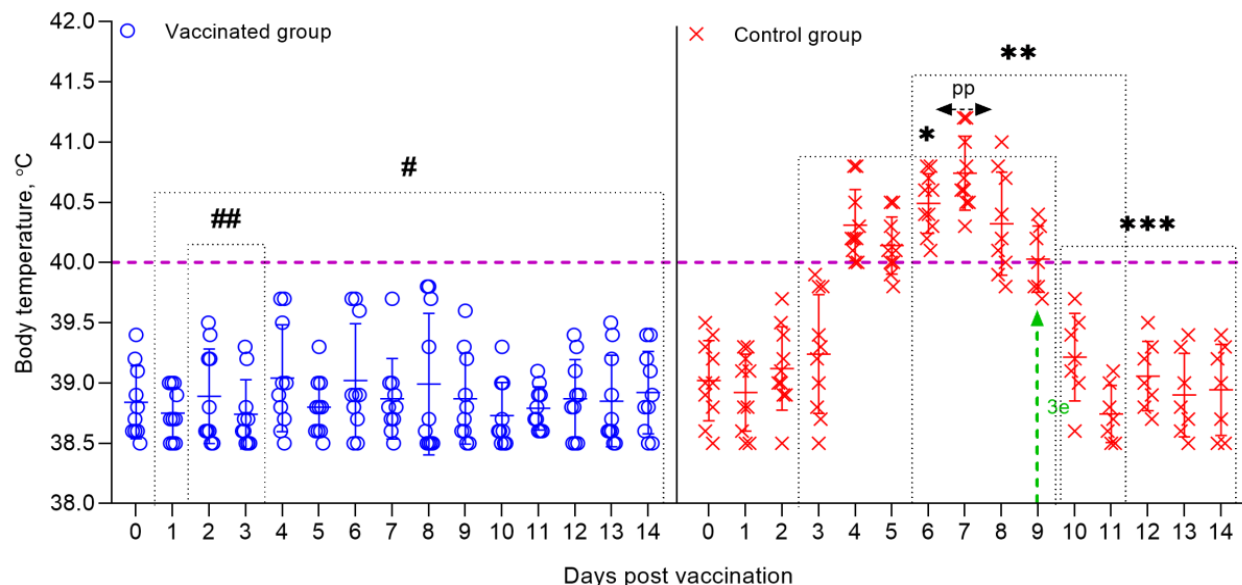
Figure 8. Dynamics of changes in the body temperature of sheep vaccinated and control groups post-challenge with the virulent strain A of the SPPV. Rectal temperatures of ten animals in each group are shown in the graph. The dotted line in graph shows the upper limit of the normal body temperature. (#) Within 14 days, in the vaccinated animals, no clinical symptoms characteristic of SPPV were observed, with the exception of local reactions in three sheep. (##) Local reactions that appeared post challenge in vaccinated sheep existed for 2–3 days. (*) Starting on the 2nd dpc, unvaccinated sheep developed local reactions in the form of edema of a dense consistency. (**) From 5 to 12 days, the control animals developed clinical symptoms, such as watery and mucopurulent discharge from the eyes and nose, papules, hyperemia in the oral cavity, decreased appetite, and depression. (3 e) On day 9, 3 sheep from the control group were humanely euthanized post-challenge due to the deterioration of their general condition. (pp) The peak of pyrexia in unvaccinated animals was noted on the 7 th dpc. (***) During the specified time intervals (from 10 to 14 days), 7 out of 10 infected animals remained alive and began to recover.